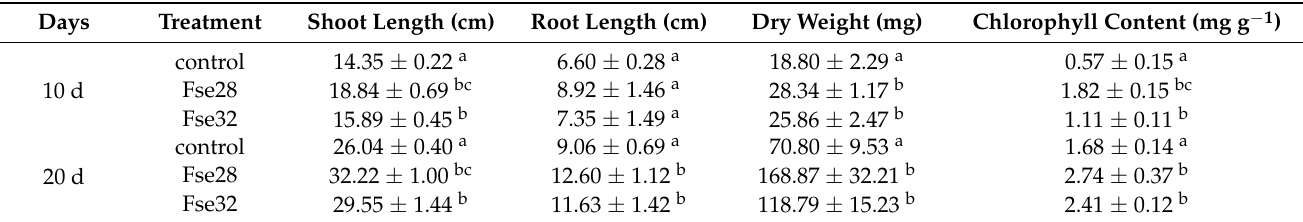
Table 4. Effects of inoculation with two PGPE strains on different growth parameters in rice after transplantation for 10 and 20 days.